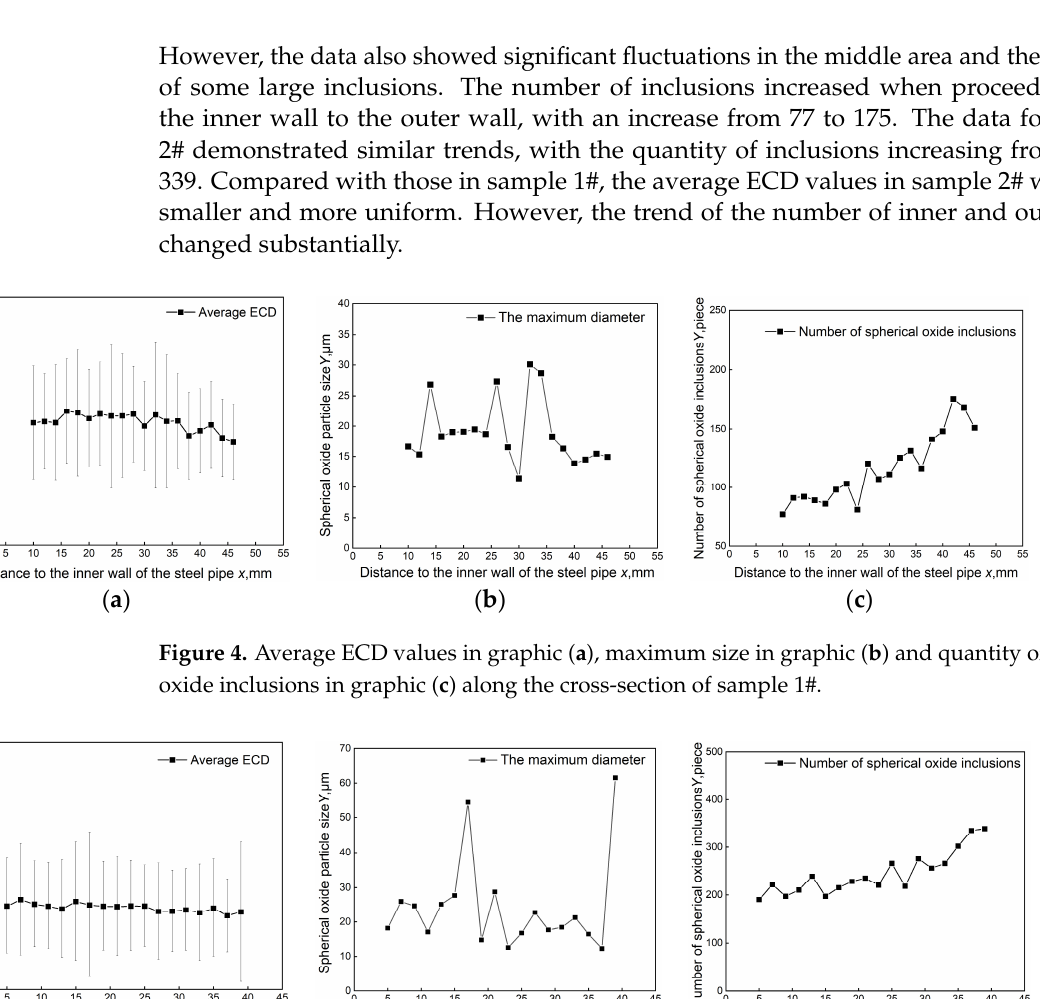
Figure 5. Average ECD values in graphic ( a ), maximum size in graphic ( b ) and quantity of spherical oxide inclusions in graphic ( c ) along the cross-section of sample 2#.